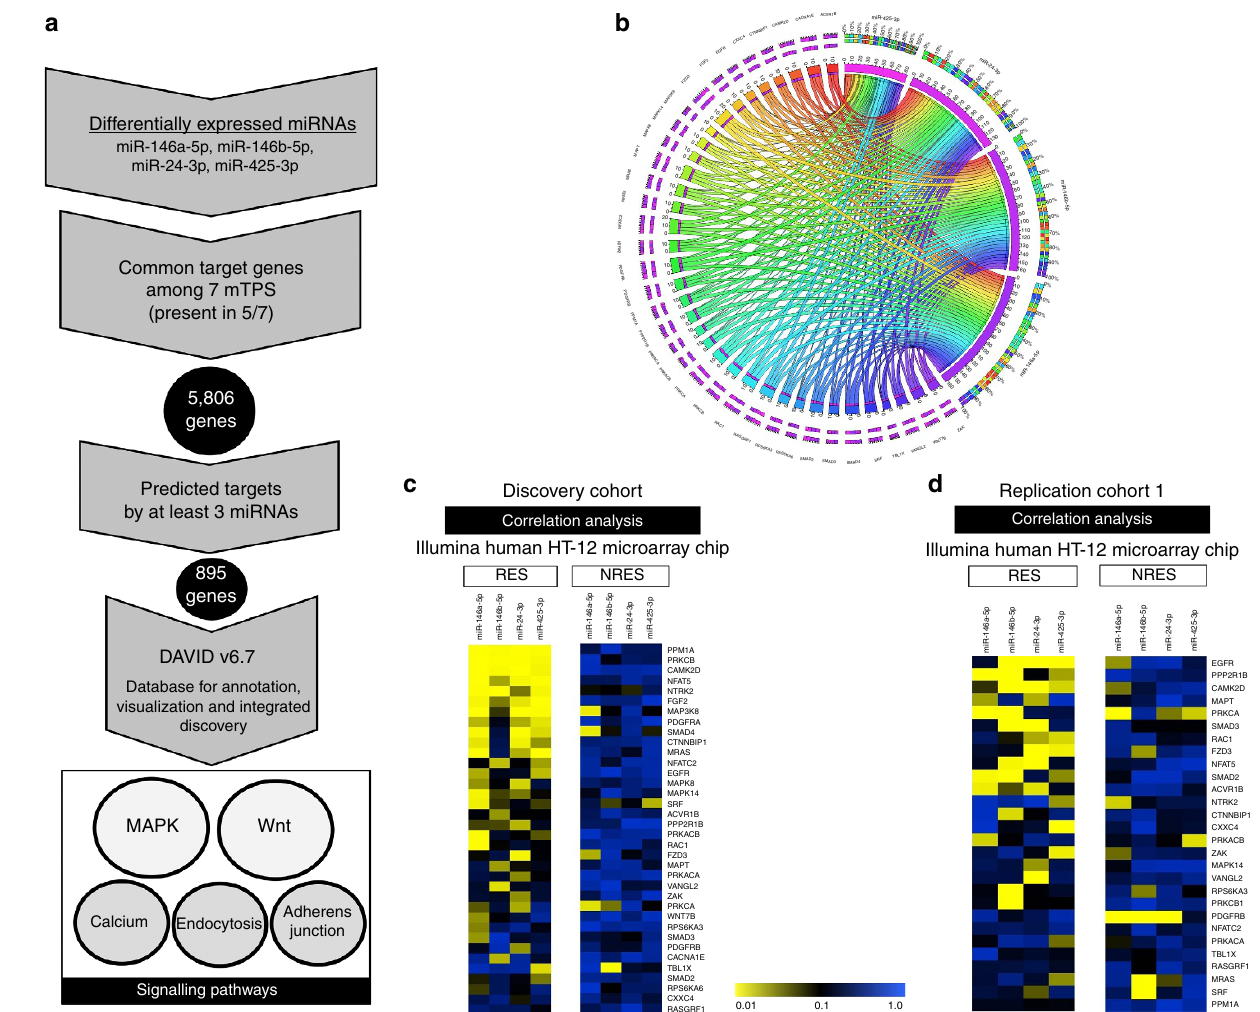
Figure 4 | Target prediction analysis and miRNA regulation of MAPK and Wnt signalling after antidepressant treatment. ( a ) Target prediction analysis using seven miRNA target prediction sites (mTPS): miRWalk 2.0, miRDB, miRanda, RNA22 v2, RNAHybrid, TargetScan and DIANA Tools. Biological pathway analysis using the Database for Annotation, Visualization and Integrated Discovery (DAVID) v6.7. ( b ) Circo graph shows the relationship between miR-146a-5p, miR-146b-5p, miR-24-3p and miR-425-3p with 36 predicted MAPK and Wnt genes identified through our in silico analysis. Each ribbon connects a miRNA with a predicted target gene. ( c , d ) Correlation analysis between miR-146a-5p, miR-146b-5p, miR-24-3p, miR-425-3p and MAPK/Wnt genes in the discovery and replication cohorts. Heatmap represents P values of Pearson’s information for the development of diagnostic tools, precau- tionary approaches and successful pharmacological interven- tions for MDD.